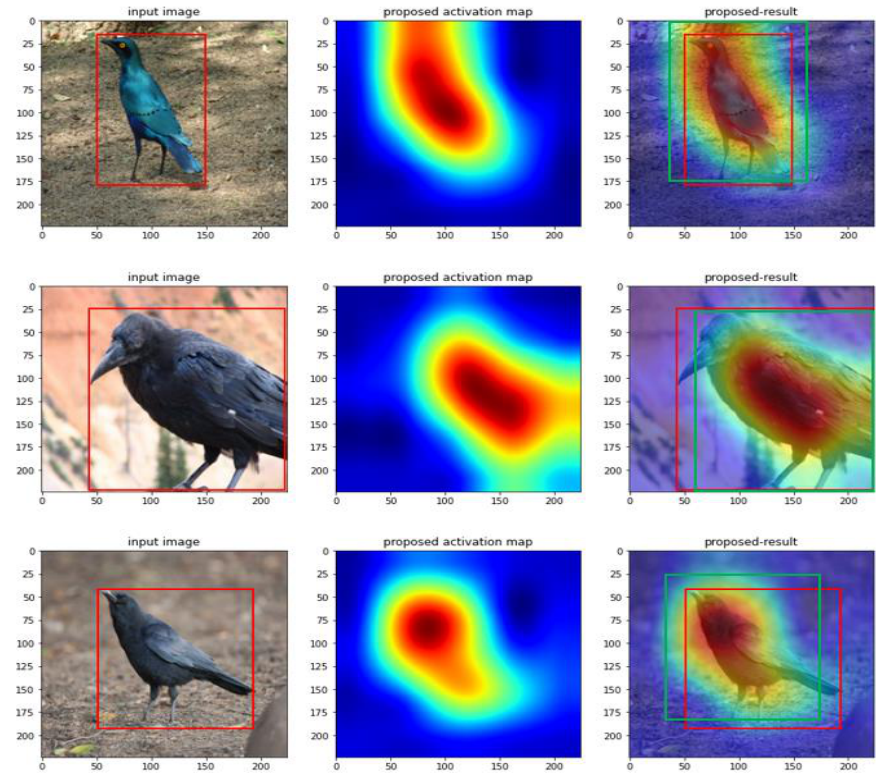
Figure 7. Results of the proposed method (3) .